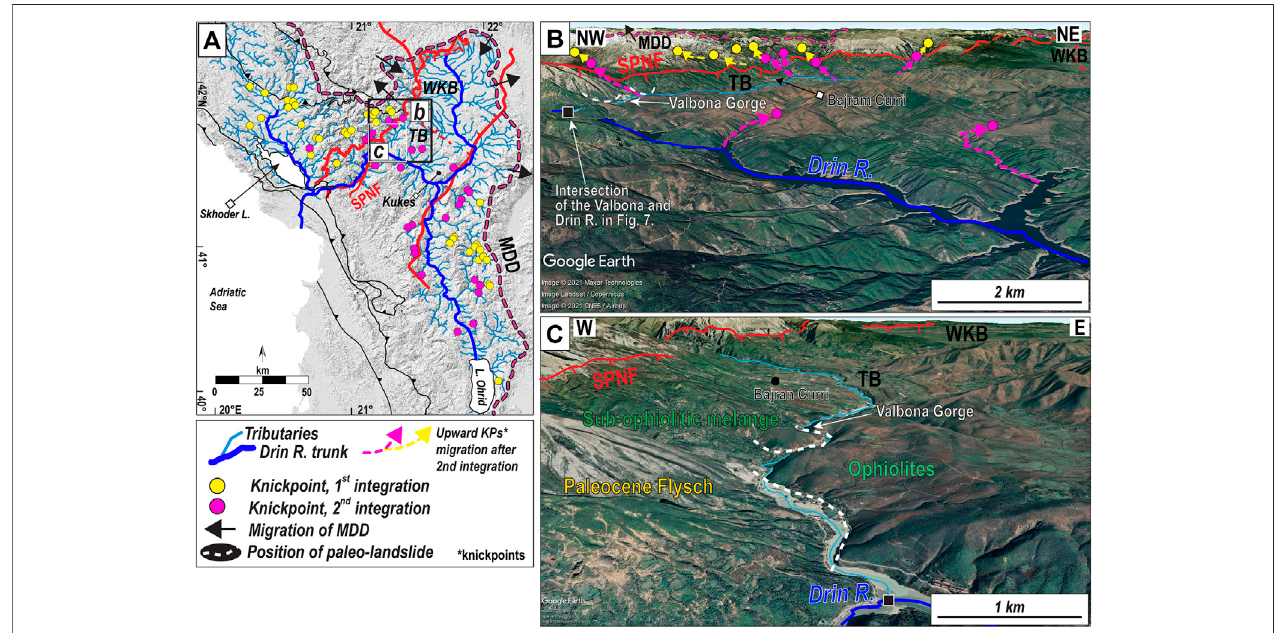
FIGURE 10 | Knickpoints along rivers in the Drin catchment: (A) Two knickpoint generations as a function of distance from the Drin River trunk (blue stream): fi rst generation – yellow dots, second generation – pink dots, as in Figure 7 . Youngest knickpoints coloured red in Figure 8 are not shown here. Black arrows indicate the predicted migration direction of the main drainage divide (MDD) as shown in Figure 9B ; (B) Bird ’ s-eye view of the two generations of knickpoints in the vicinity of the TropojaBasin(TB).Pink arrows – migrationdirectionofsecondgenerationofknickpoints; Yellow arrows – upstream migrationdirectionof fi rstknickpoint generation followed by second integration of the Drin River (see text for explanation); (C) Bird ’ s-eye view of the Valbona gorge and intersection with the Drin River trunk. Dashed white lines indicate the possible location of the former toes of paleo-landslides that may have dammed the Valbona River downstream of the TB. These are based on a qualitativeanalysisfrom Google earth and from the landslide inventory map ofAlbania (Jaupajet al., 2017). Images from Google Earth ™ , 42 ° .13 ‘ N, 20 ° 11 ‘ E,7/22/2021.